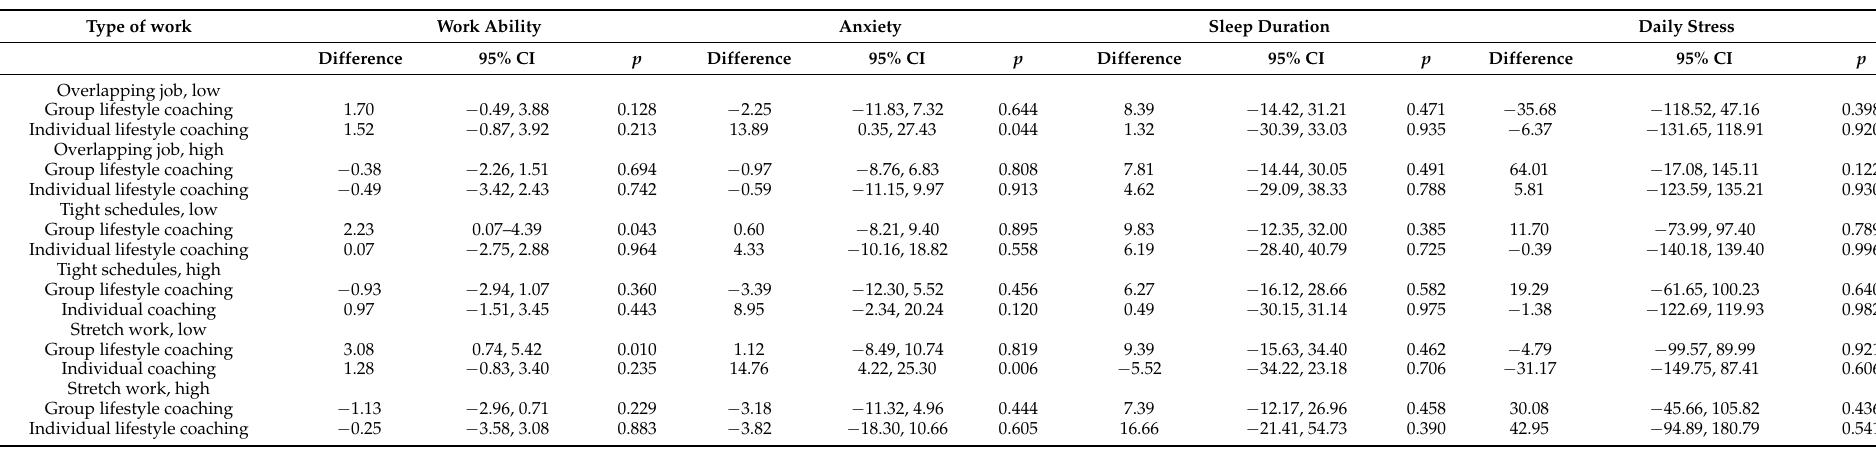
Table 5. The results of imputed data on the effects of lifestyle coaching on work ability, anxiety, sleep duration, and daily stress among participants with low or high overlapping jobs, tight schedules, and stretching